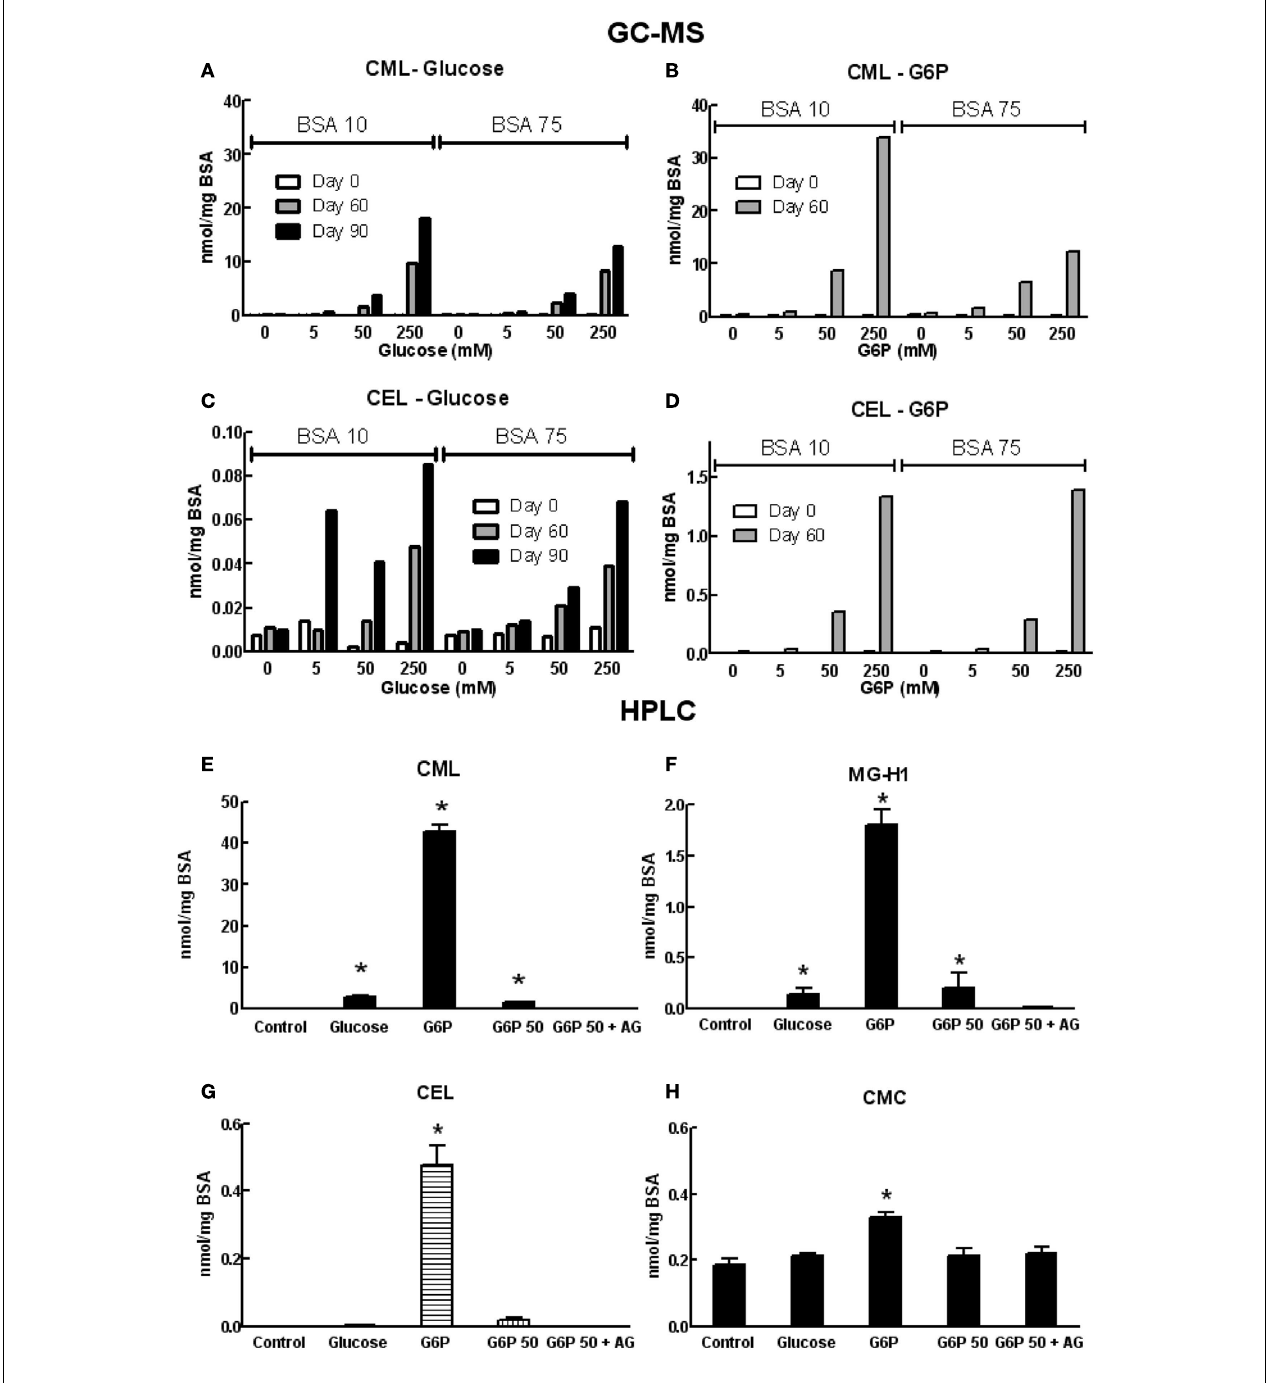
a single sample; columns in (E–H) represent the mean ± SEM for three separate batches of BSA glycated under identical conditions and each sample was read in duplicate. *Indicates significant increase from control ( P < 0.05, t